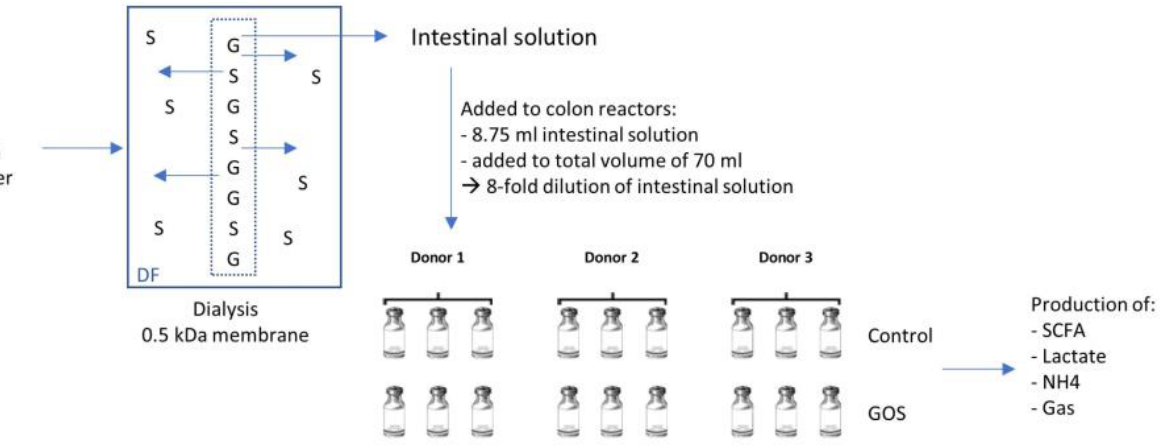
Figure 1. Experimental approach. GOS (provided by Clasado Biosciences Ltd., Reading, UK) was dialyzed prior to colonic incubation to simulate absorption during small intestinal passage. GOS stock solutions (40 g/L) were prepared in water and added inside dialysis membranes (0.5 kDa pore size). Membranes were sealed and the stock solution was dialyzed for 24 h in a dialysis fluid (DF) to allow for monosaccharides and disaccharides (S) to pass through the membrane, whereas larger